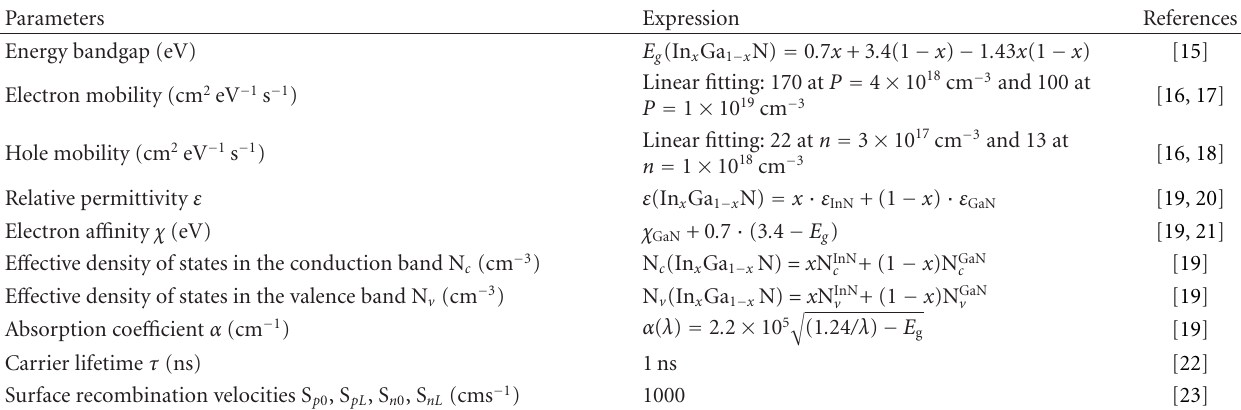
Table 1: The simulation parameters for In x Ga 1 − x N materials at 300 K